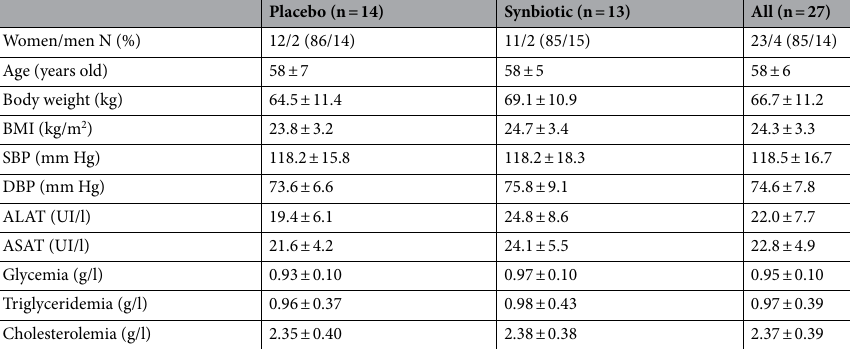
Table 1. Baseline characteristics of participants. Values are means ± SD. Baseline data were analyzed by Mann–Whitney test for continuous variables (p > 0.05) and Fisher test for categorical variables (ratio women/ men; p > 0.05). ALAT alanine aminotransferase, ASAT aspartate aminotransferase, BMI body mass index, DBP diastolic blood pressure, SBP systolic blood pressure.